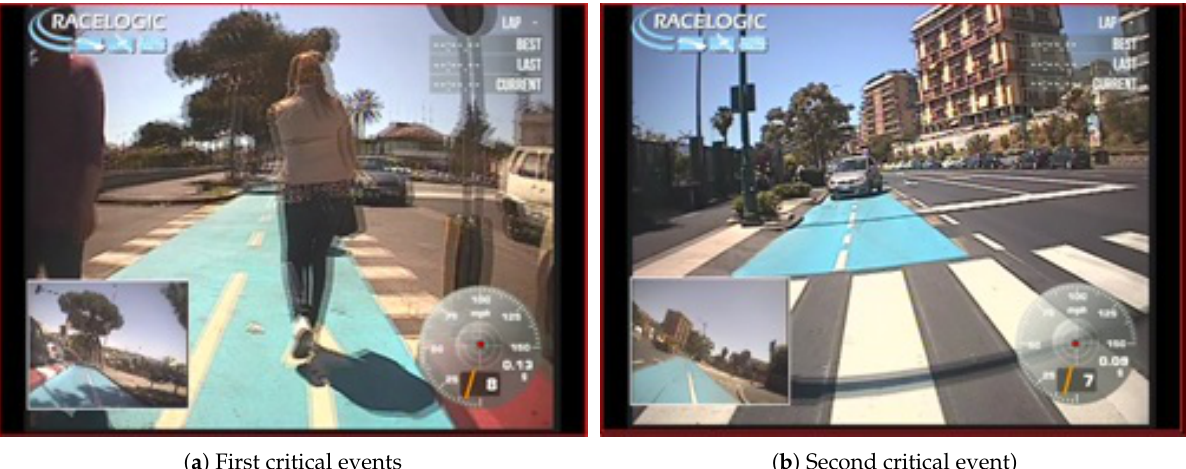
Figure 15. L1—Critical events occurred during the riding.